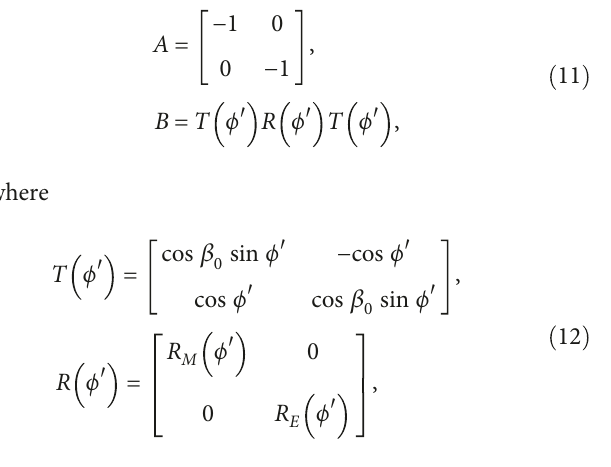
Figure 9: Phase of electric fi eld of the ϕ component in the ϕ =20 ° plane with w =4 λ and h =1 λ , at 4GHz compared with simulation result.